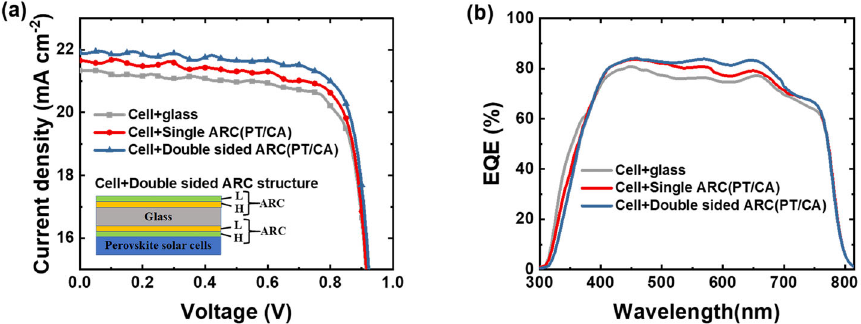
Figure 5. ( a ) J ‐ V curves and ( b ) EQE plots. H: high ‐ refractive ‐ index hybrid material PT; and L: low ‐ Figure 5. ( a ) J-V curves and ( b ) EQE plots. H: high-refractive-index hybrid material PT; and L: refractive ‐ index material CA. The perovskite solar cell with the PT/CA structured single ‐ sided and low-refractive-index material CA. The perovskite solar cell with the PT/CA structured single-sided double ‐ sided antireflective films was prepared and attached as the cover glass, respectively. and double-sided antireflective films was prepared and attached as the cover glass,